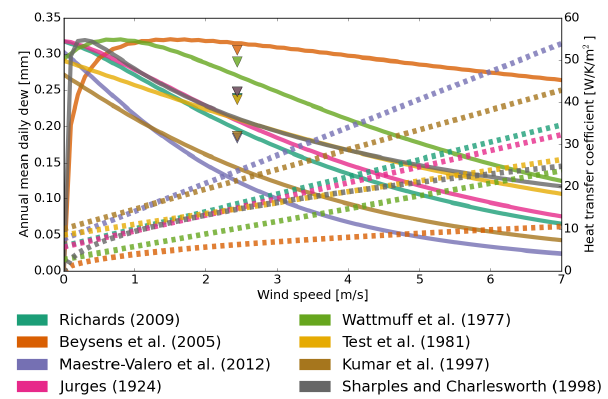
Figure 2. Sensitivity of the model to the heat transfer coefficient. The dashed lines represent heat transfer coefficients for different parameterizations as functions of wind speed. The triangles repre- sent annual mean daily yields of dew using one year of ERA-Interim data for the grid point closest to the Negev Desert, Israel (30.75 ◦ N, 34.5 ◦ E) in 1992 (here plotted against the annual mean wind speed). The solid lines are the same, but the wind speed has been fixed ac- cording to x axis.